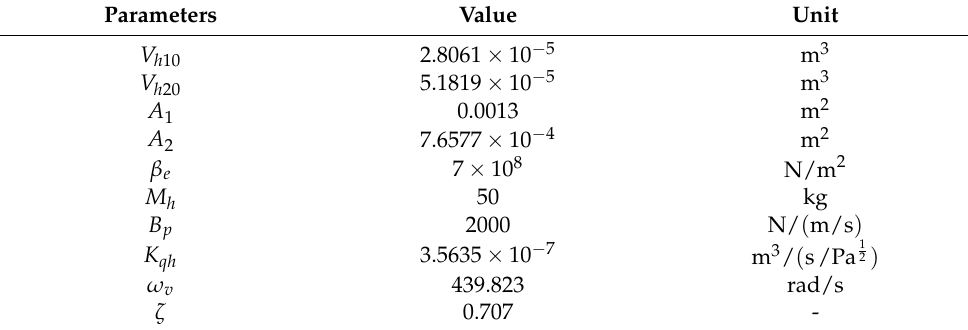
Table 5. System parameters in the simulation.